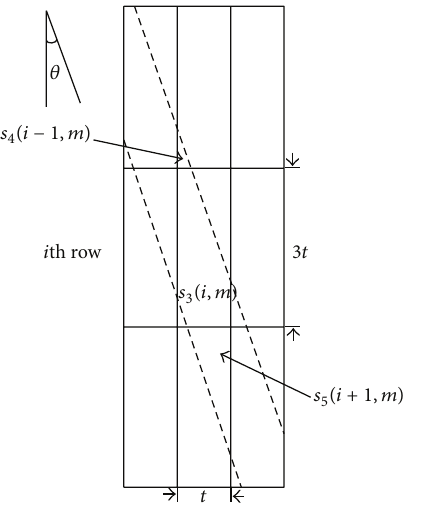
Figure 3: Illustration of system-introduced crosstalk measurement